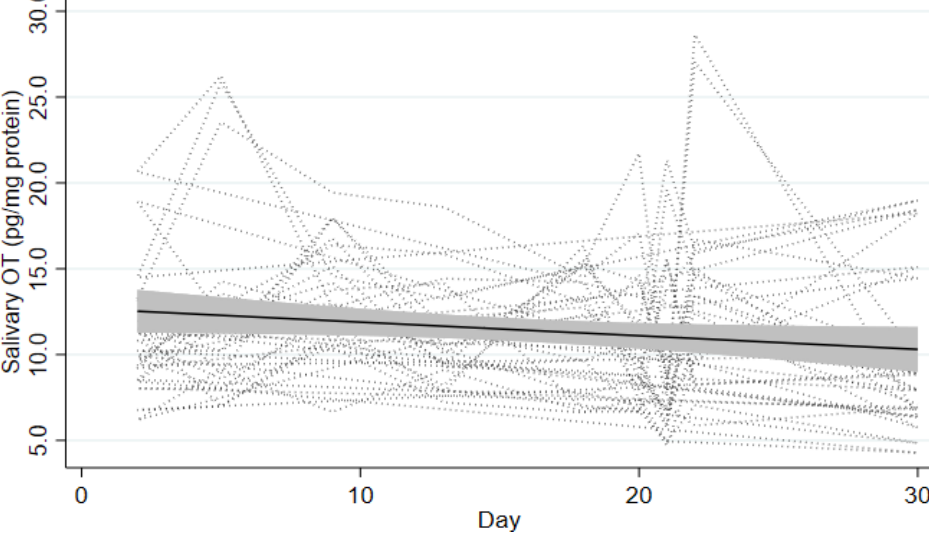
Figure 2. Trend of the oxytocin (OT) release over the course of the 31-day wilderness program Note: The dotted line with gray area indicates a regression line with 95% confidence interval.